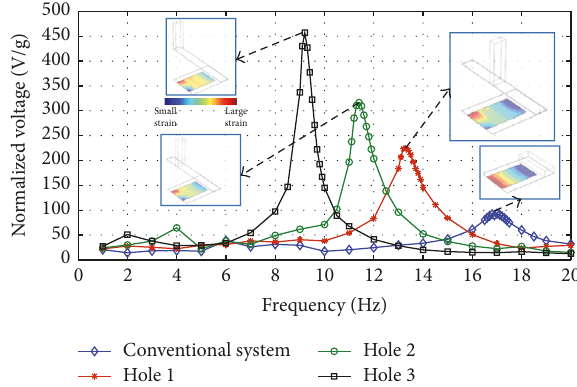
Figure 5: Normalized output voltages from experiments: insets are the relative total strains at resonance from FEM simulations.